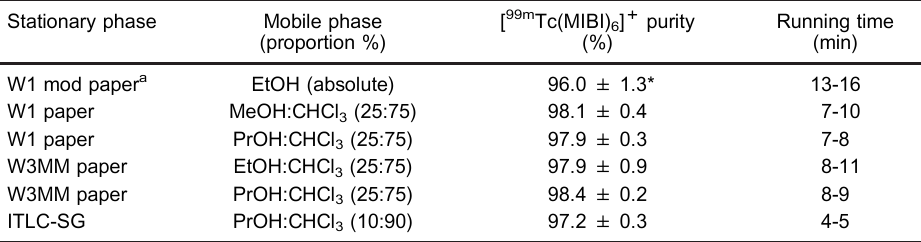
Table 3. Behavior of [ 99m Tc(MIBI) 6 ] + in several chromatography systems, with chromatographic strips cut at half of the run size (6 cm). Stationary